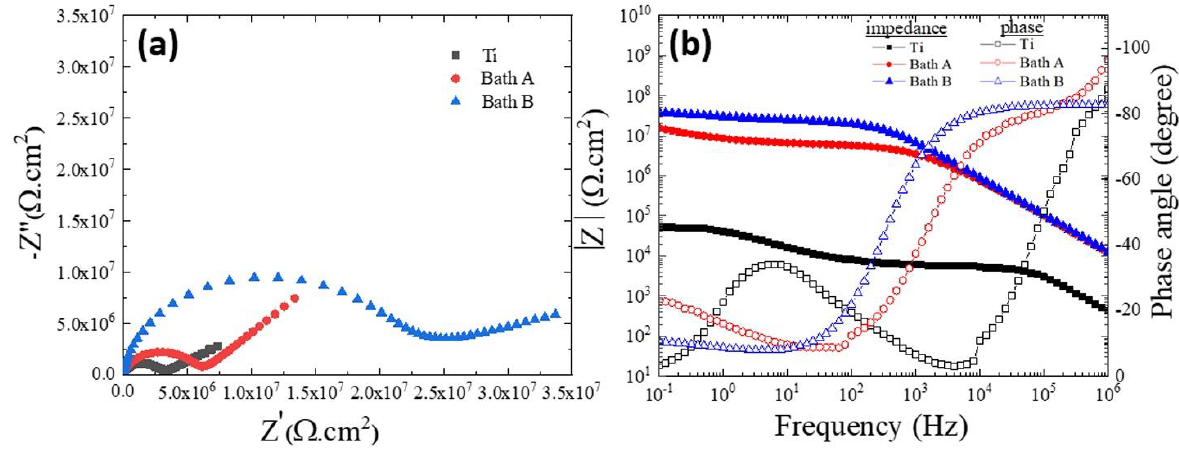
Figure 8. ( a , b ) Nyquist and Bode plots (impedance and phase angle) of the coatings obtained in Baths A and B after immersion in a 3.5 wt.% NaCl solution for 5 h where ( a ) Nyquist plots and ( b ) Bode plots.